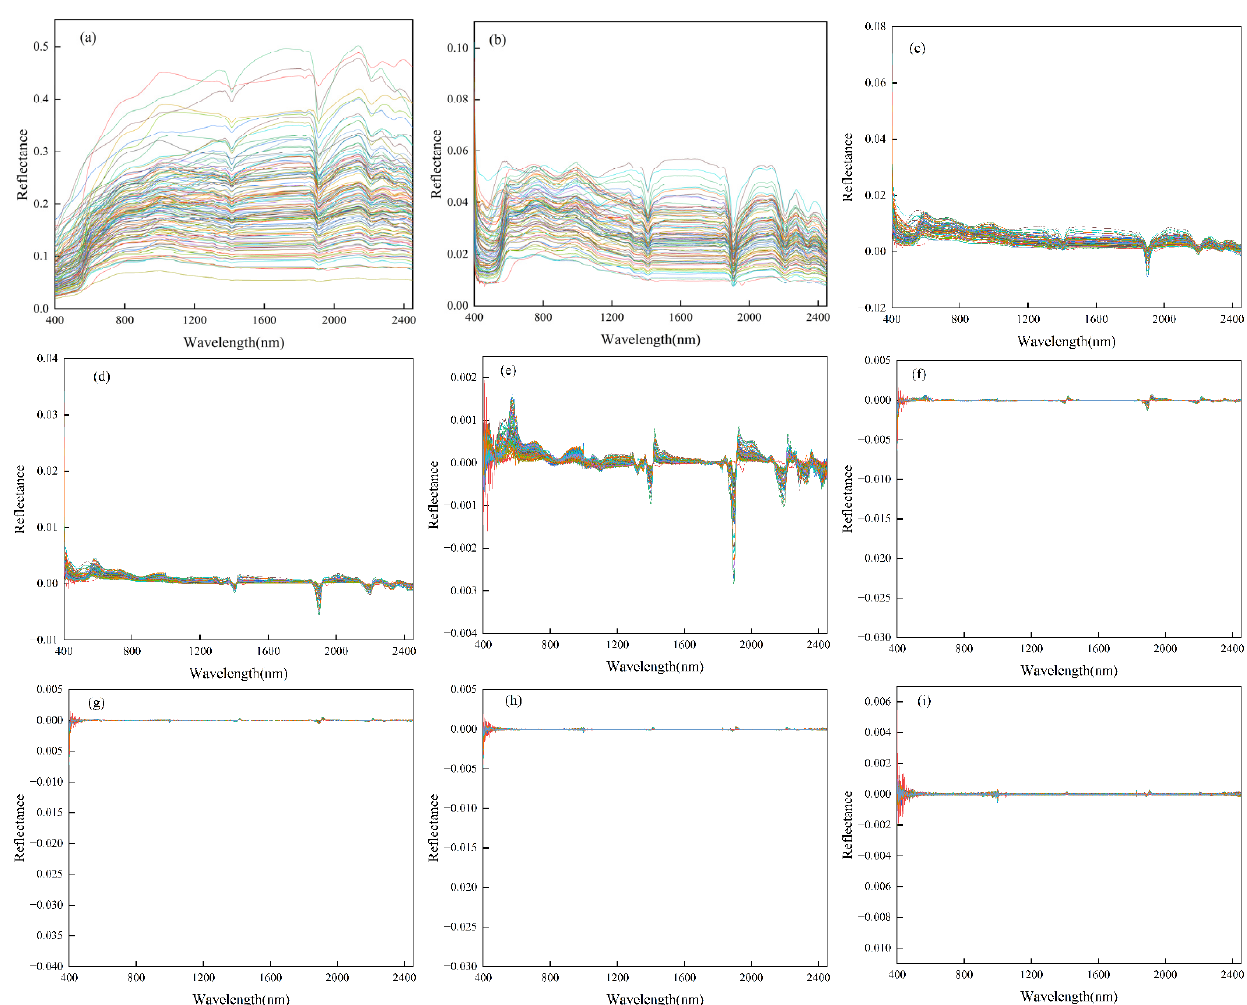
Figure 5. The FOD spectra of soil samples in the calibration dataset: ( a ) original spectra; ( b ) 0.25-order, ( c ) 0.5-order; ( d ) 0.75-order; ( e ) 1-order; ( f ) 1.25-order; ( g ) 1.5-order; ( h ) 1.75-order; ( i ) 2-order.